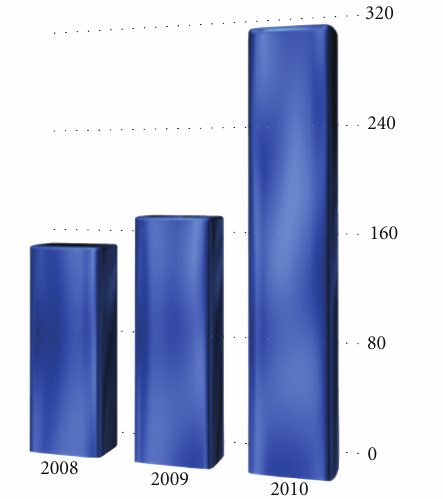
Figure 2: Worldwide smartphone sales (in millions).